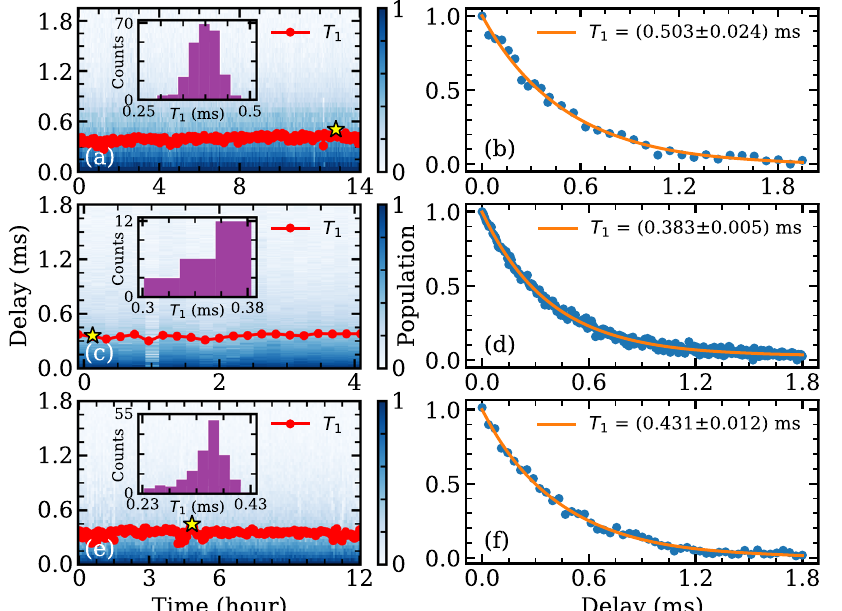
Fig. 1 The relaxation times of three qubits. Panels a , c , e show relaxation times of Q 3 in Ta-4 chip, Q 1 in Ta-3 chip, and Q 1 in Ta-2 chip measured in 14, 4, and 12 h, respectively. The insets are the corresponding histograms, and the yellow stars indicate the best relaxation time values during each time interval. The orange lines in b , d , f are the fi tting curves of the best relaxation measurement results, respectively; the average and best times are 401 μ s and 503 μ s for Q 3 in Ta-4, 356 μ s and 383 μ s for Q 1 in Ta-3, and 359 μ s and 431 μ s for Q 1 in Ta-2, respectively.